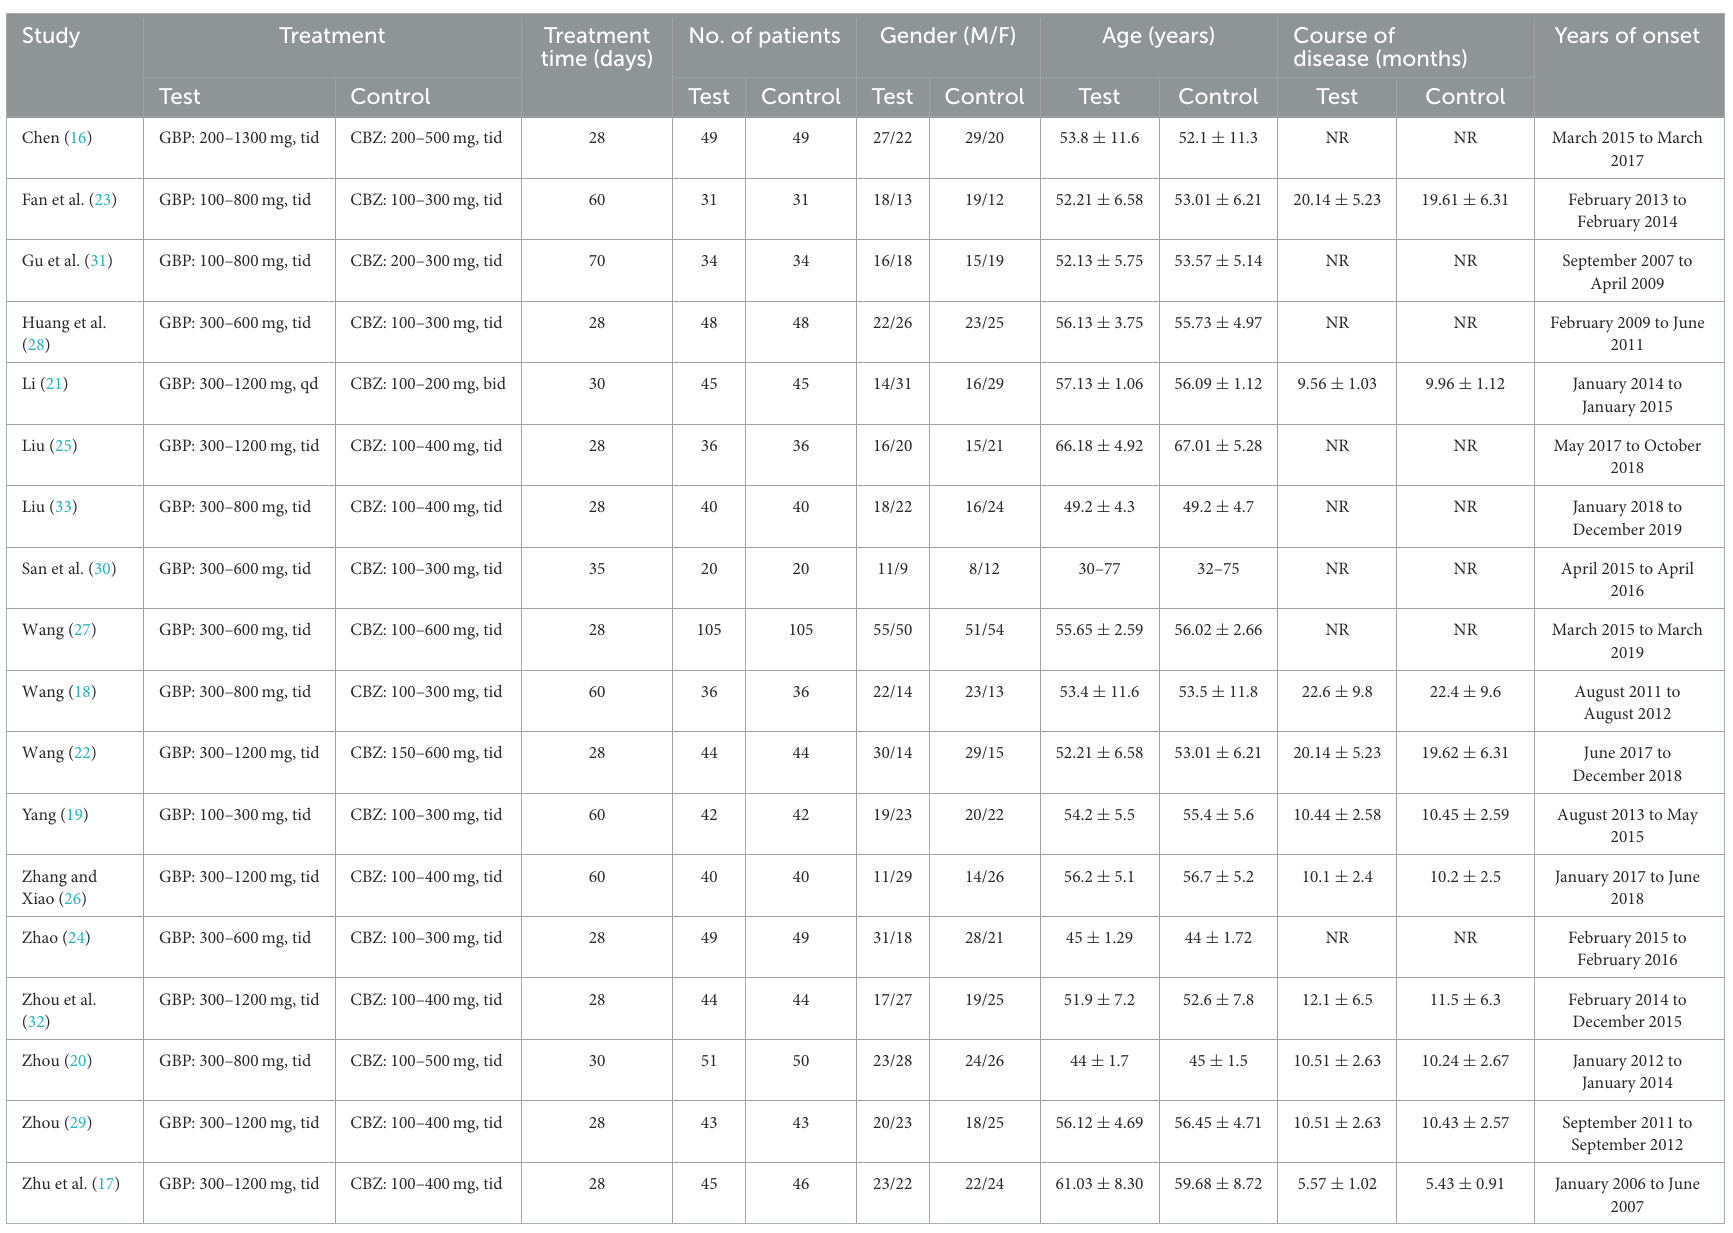
TABLE 1 Presentation of main characteristics for included